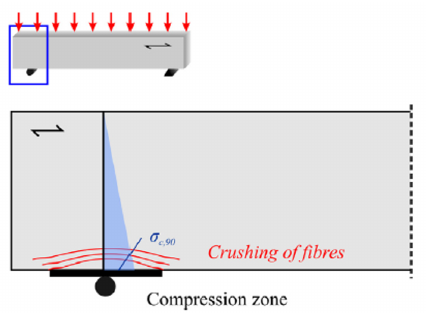
Figure 4. Sketch for compression failure [9].